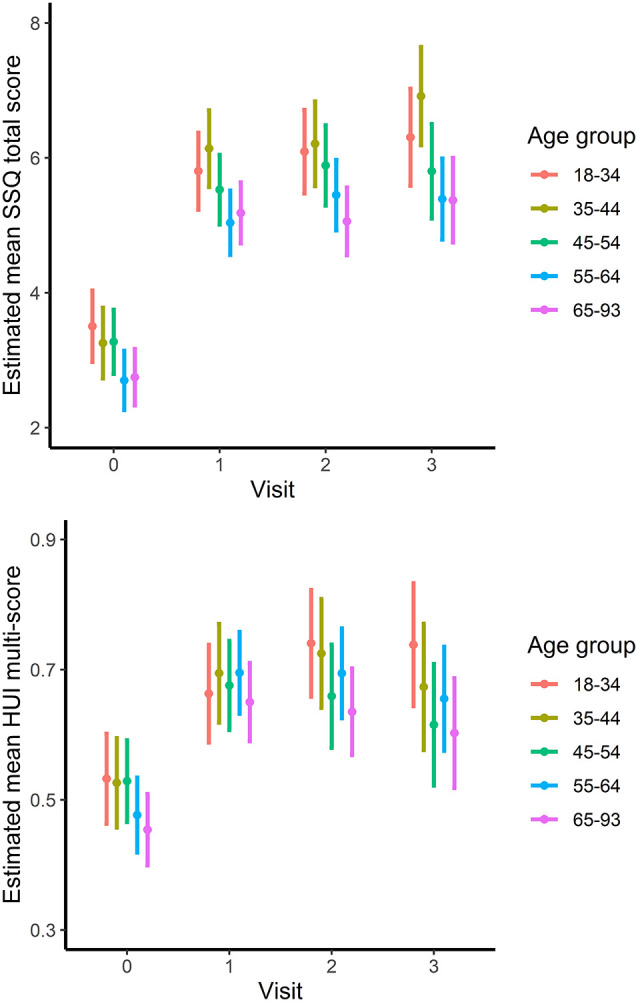
SSQ (upper) and HUI (lower) scores by visit for each age group. Points and lines indicate least-squares means with 95% confidence intervals.